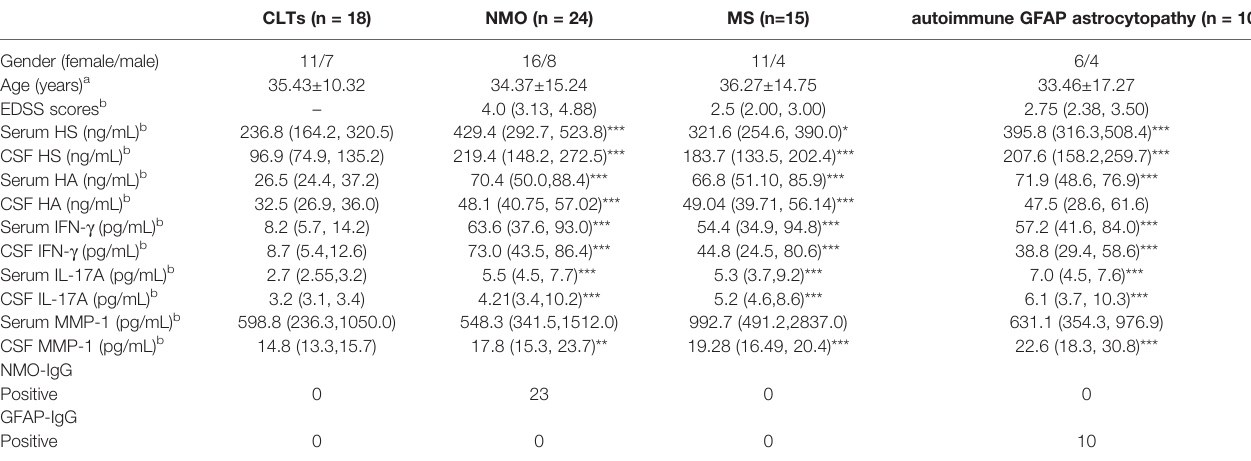
TABLE 1 | Demographic and clinical features of the patients and controls.